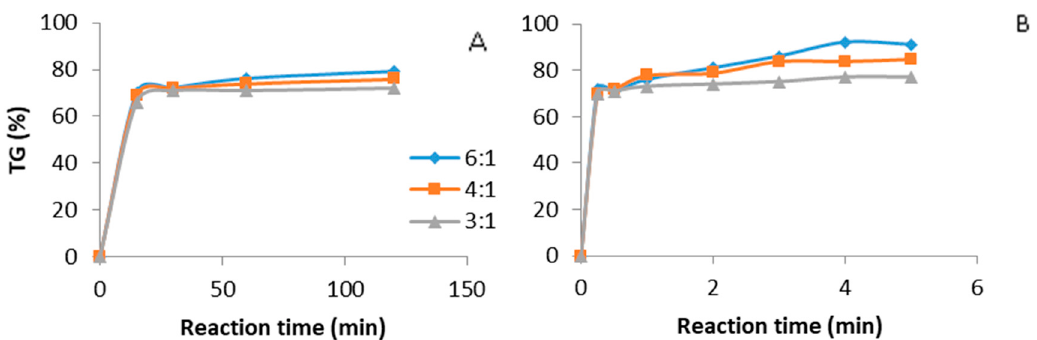
Figure 4. Biodiesel production. Catalyst NaOH, 0.5 wt %, methanol: oil ratio (6:1, 4:1, 3:1). ( A ) Mechanical stirring batch reactor, temperature 65 °C. ( B ) Ultrasound batch reactor, ultrasound amplitude 60%, temperature 35 °C.